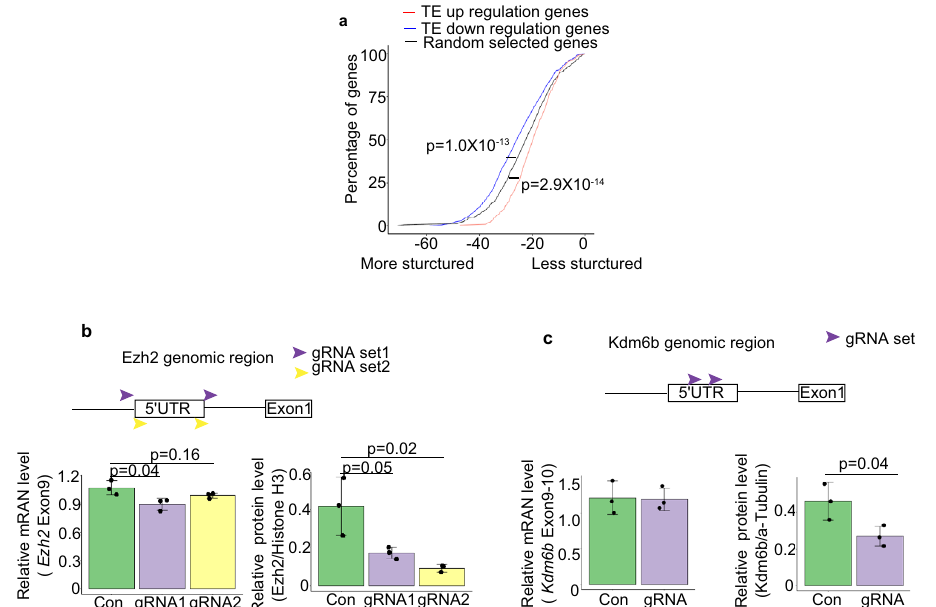
Fig. 8 Fbl regulates translation through the 5 ′ UTR in a cap-independent manner. a 5 ′ UTR minimum free energy (MFE) cumulative distribution of mRNAs showing changes in translational ef fi ciency (TE) after Fbl knockout. Randomly selected mRNAs are shown as controls (two-sided Wilcoxon signed-rank test). b , c Changes in mRNA (left) and protein levels (right) after Ezh2 ( b ) and Kdm6b ( c ) 5 ′ UTR knockout ( n = 3; one-way ANOVA followed by Tukey ’ s tests ( b ) and two-sided Student t test ( c ); data are presented as mean ±